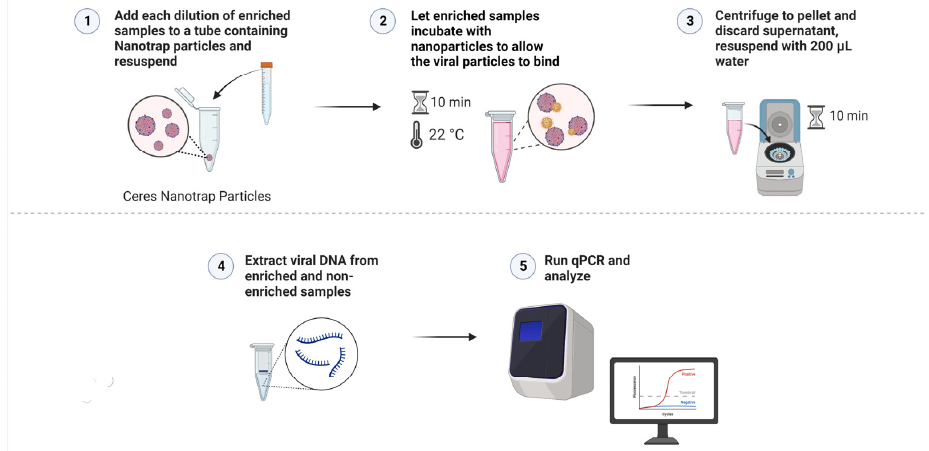
Figure 3. A visual protocol demonstrating the use of Nanotrap Red particles to enrich the samples and the processes of DNA extraction and PCR that followed (Created with BioRender.com).